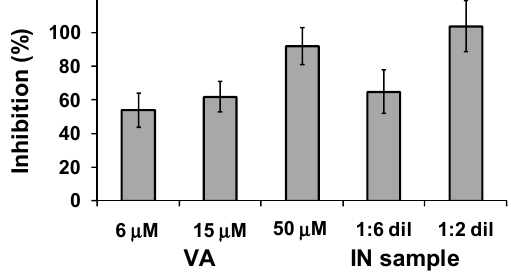
Figure 3. Inhibition of self-induced A β 1-42 aggregation by VA and IN sample at different dilutions. Reported are the mean ± SD values from at least three experiments.